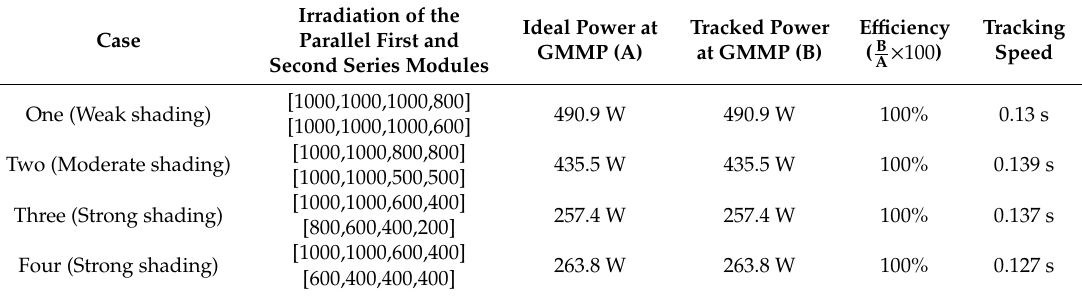
Table 3. Detailed performance of the proposed